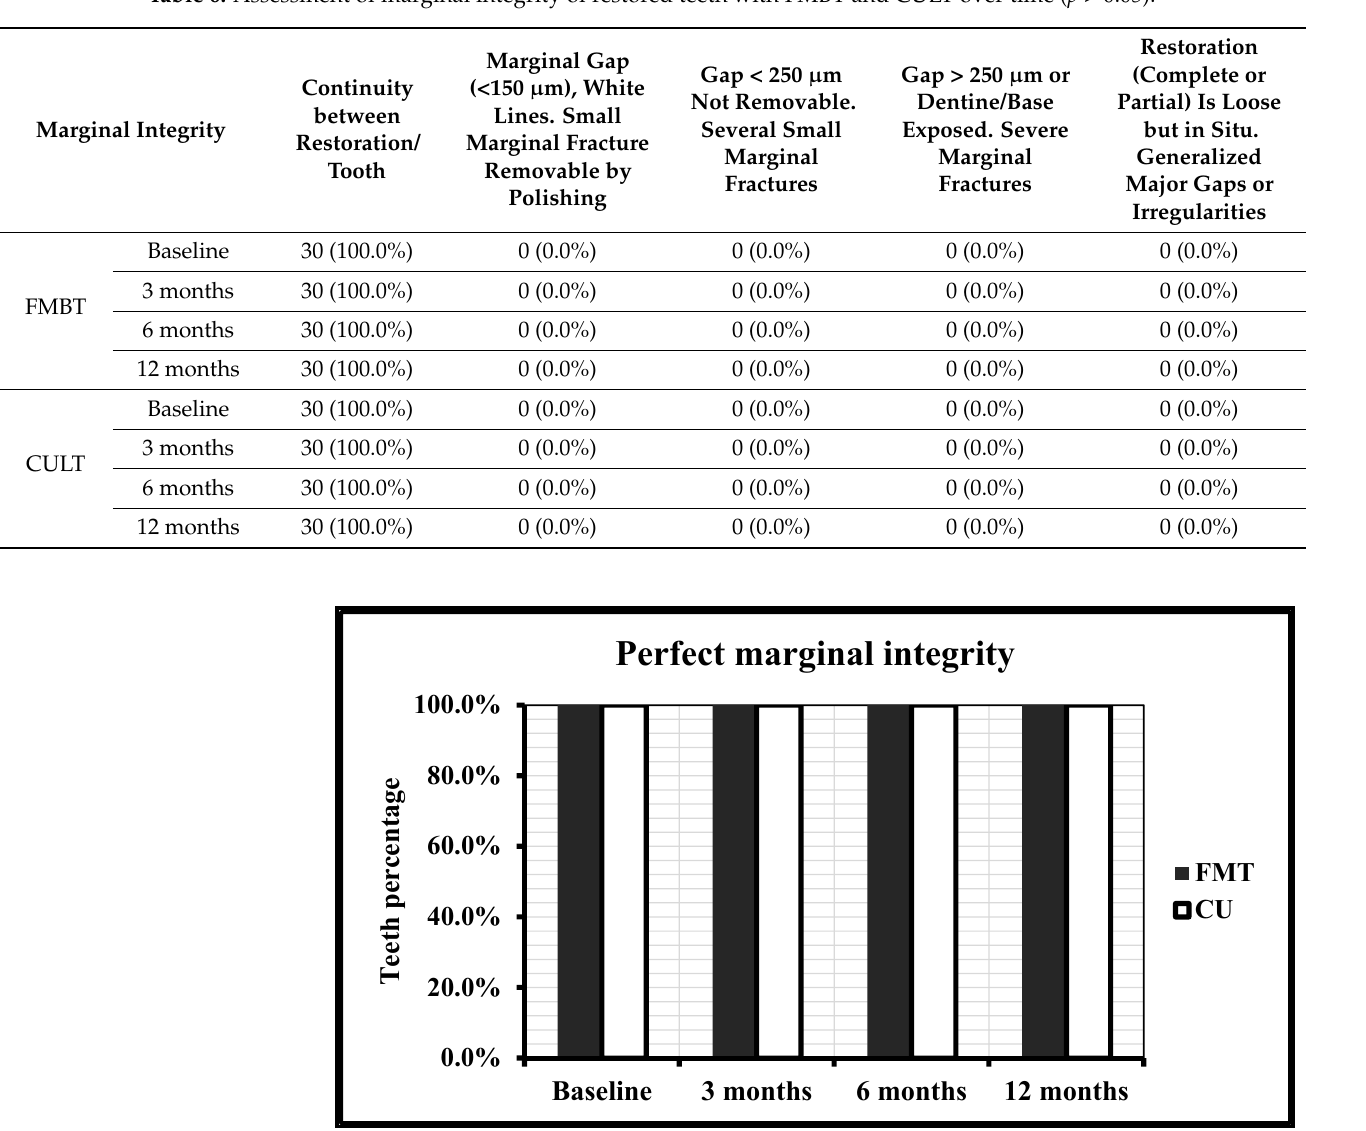
Figure 6. Absence of secondary caries in teeth restored with FMBT and CULT over time.